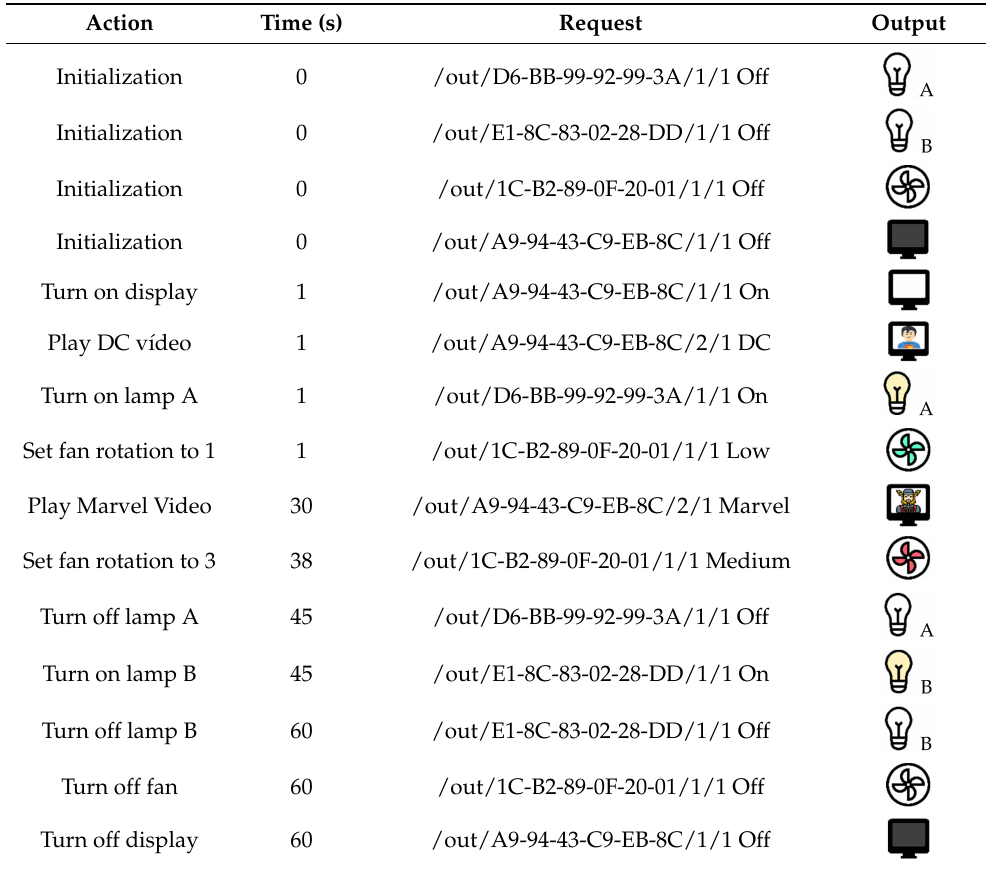
Table 8. Three-dimensional environment virtual devices: schedule-oriented control testing